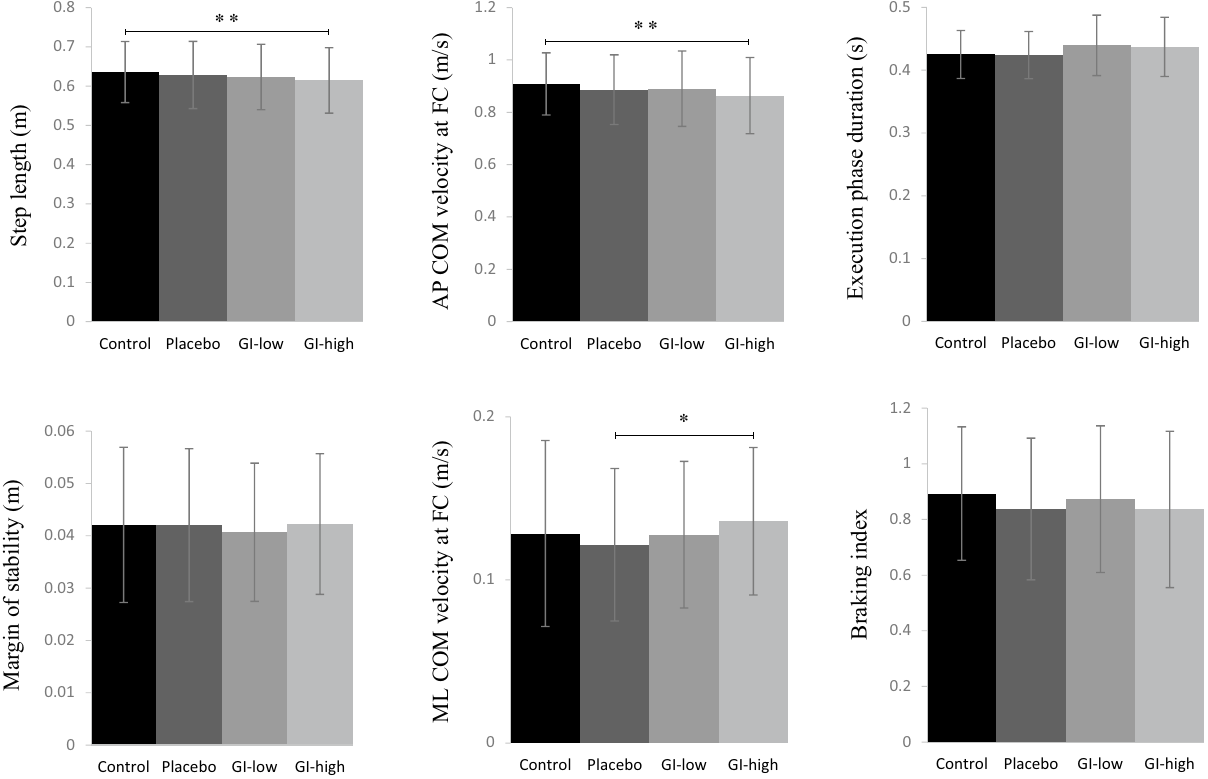
Figure 3. Effects of the condition on motor performance (upper panels) and stability parameters (bottom panels). Reported are mean values (all participants together) + 1 SD. AP, ML anteroposterior, mediolateral; COM centre-of-mass; FC foot-contact; *, **: significant difference between bars with p < 0.05 and p < 0.01,